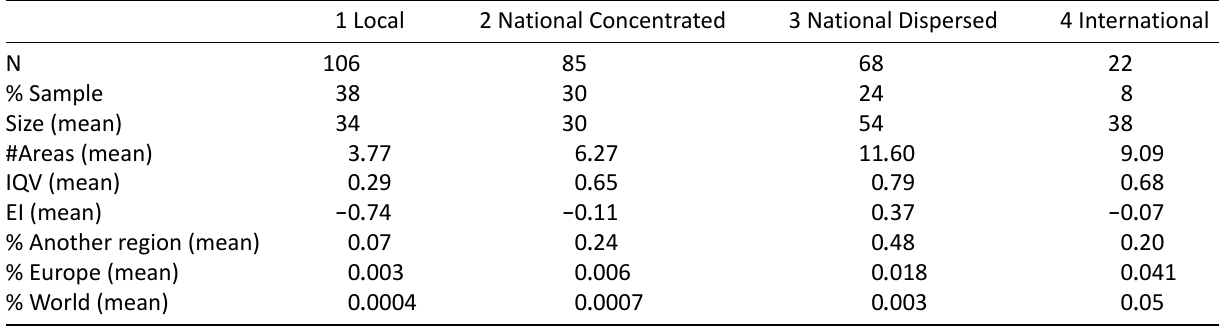
Table 3. Description of groups by the indices (Caen Panel, N =